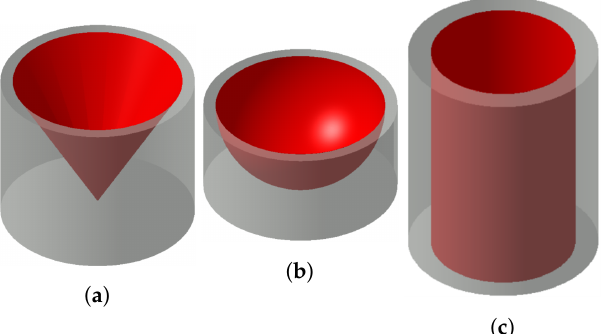
Figure 15. Existing cavity design models for numerical ray tracing: ( a ) negative conical cavity (base diameter and slant height 110 mm, external diameter 120 mm, external height 100 mm); ( b ) hemispherical cavity (cavity diameter 110 mm, external diameter 120 mm, external height 60 mm); ( c ) cylindrical through cavity (cavity diameter 50 mm, height 121 mm, external diameter 60 mm). Red: absorption surfaces; an absorptance of 85% is selected in this